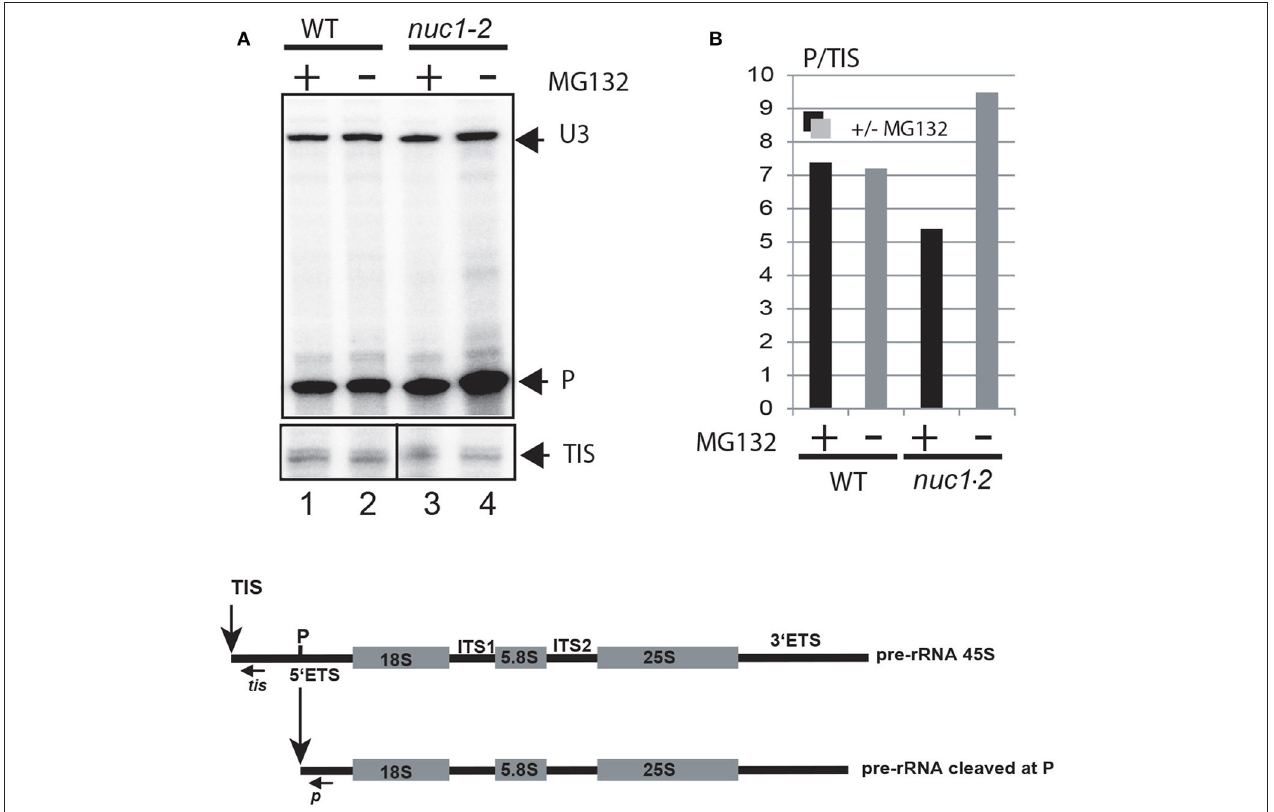
FIGURE 5 | Proteasome inhibitor affects accumulation of pre-rRNA in nuc1 .2 plants. (A) Primer extension experiments were performed using total RNA extracted from WT (lanes 1 and 2) and nuc1.2 (lanes 3 and 4) plants treated or not with MG132. The relative amount of pre-rRNA initiated at the transcriptional initiation site (TIS) and cleaved at the primary cleavage site (P) was determined using primers tis and p respectively. Mapping of U3snoRNA (U3) was performed to verify similar amount of RNA in each sample. (B) Histogram show ratio of P/TIS signals in each sample. Black and gray bars represent respectively treated and untreated samples with MG132. Below, the scheme shows the 45S pre-rRNAs, containing the external transcribed spacers (5 ′ ETS and 3 ′ ETS), and the structural rRNA sequences (18S, 5.8S, and 25S rRNA in gray boxes) separated by internal transcribed spacers (ITS1 and ITS2). The vertical arrows show the Transcription Initiation Site (TIS) and primary cleavage site (P) in the 5 ′ ETS. Positions of primers used to detect rRNA initiated at the TIS and cleaved at P sites are